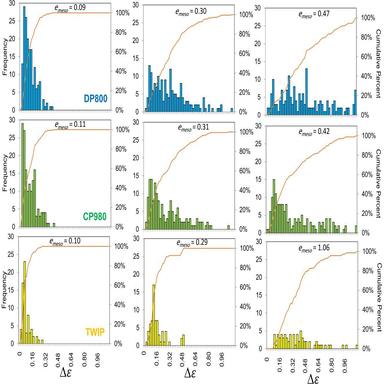
Frequency plots for the number of strain partition increments for DP800, CP980, and TWIP.